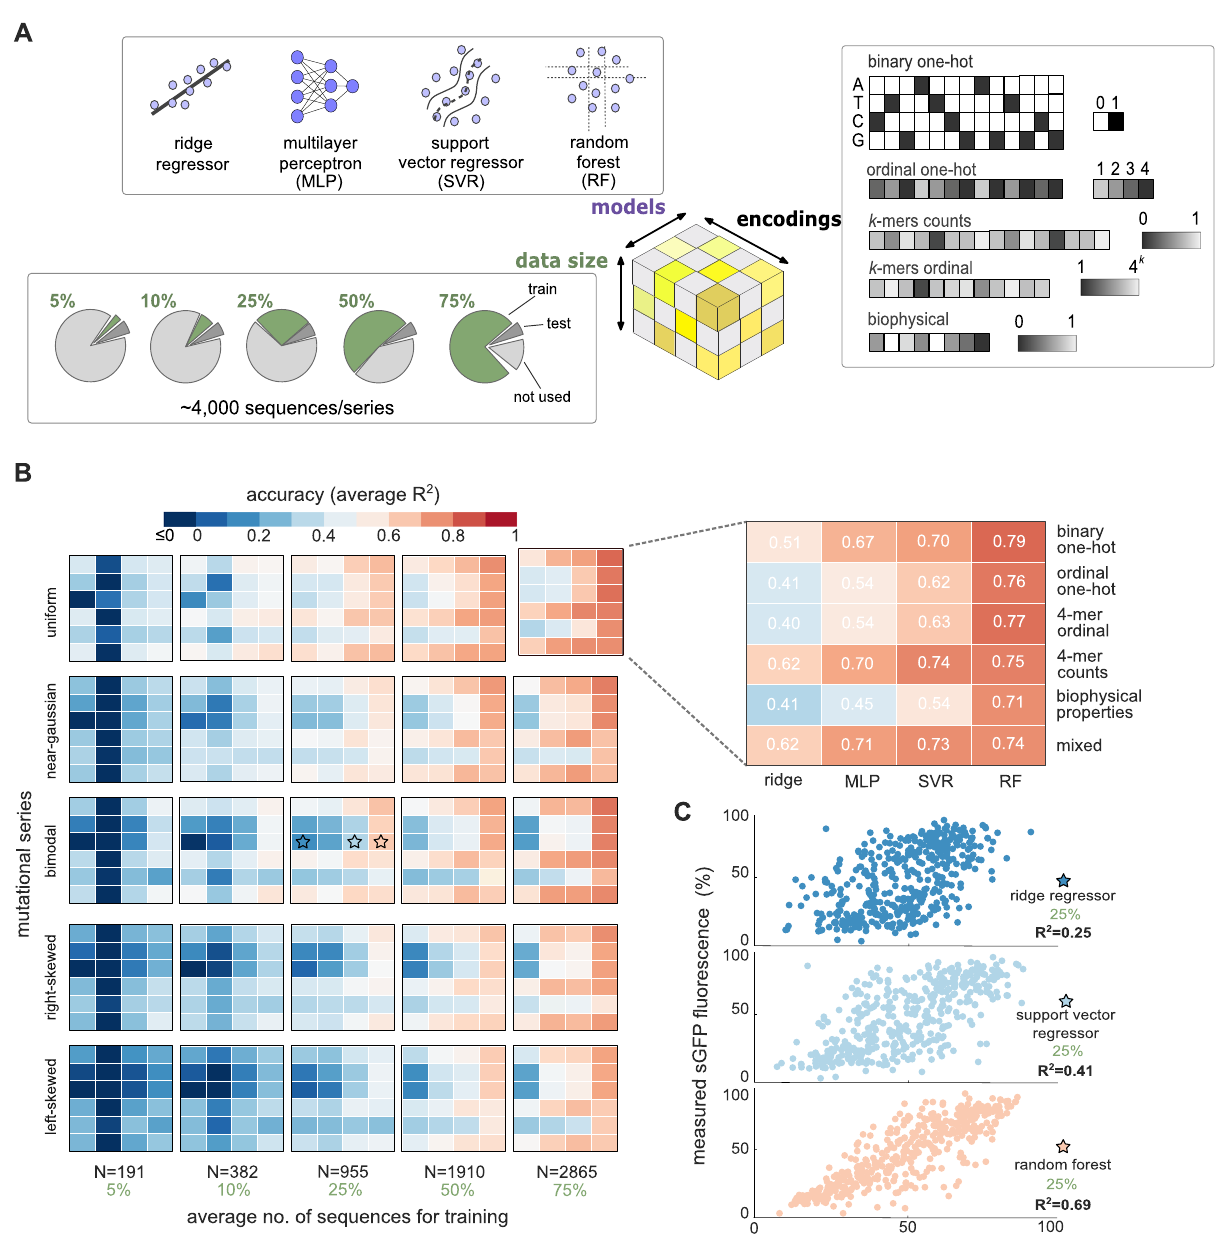
Model accuracy was quanti fi ed by the coef fi cient of determination ( R 2 ) between predicted and measured sfGFP fl uorescence, computed on ~400 test sequences held-out from training and validation. The reported R 2 values are averages across fi ve training repeats with resampled training and test sets (Monte Carlo cross- validation). In each training repeat, we employed the same test set for all models and encodings. The full cross-validation results (Supplementary Fig. S4) show robust performance and little over fi tting, particularly for the best performing models. C Exemplar predictions on held-out sequences for three models from panel B (marked with stars); the shown models were trained on 25% of mutational series44(bimodal fl uorescencedistribution;Fig.1C)using4-merordinalencoding. Details on model training and hyperparameter optimization can be found in the Methods, Supplementary Fig. S3, and Supplementary Tables S2 –